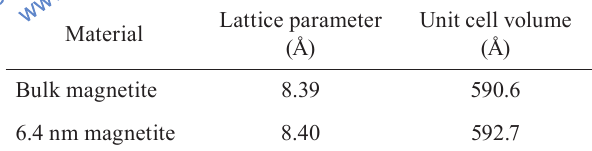
Table 2 General properties of magnetite.